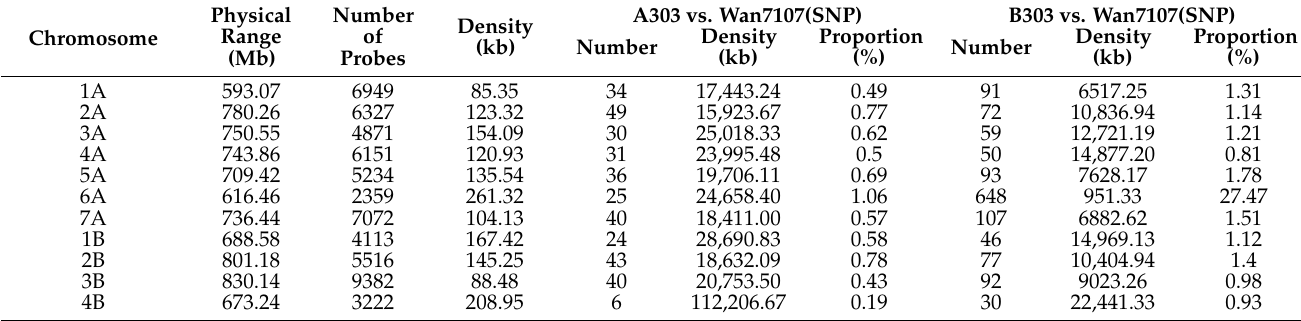
Table 2. Number, density, and proportion of SNP probes on each chromosome in homozygous Wan7107. Physical Chromosome